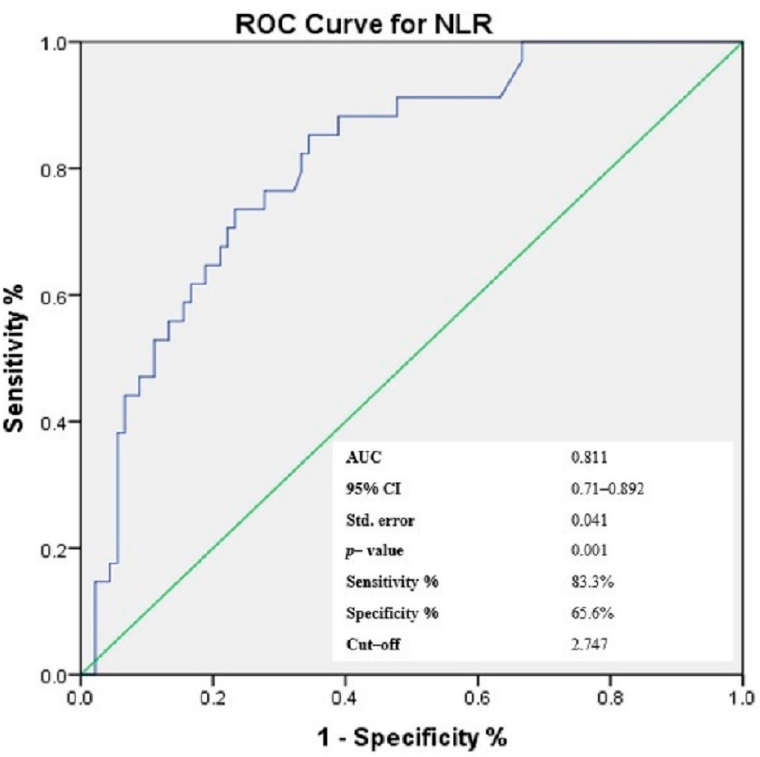
Figure 2. Receiver operating characteristic curve of NLR levels for the prediction of the cutaneous vasculitis lesions in patients with pSS.